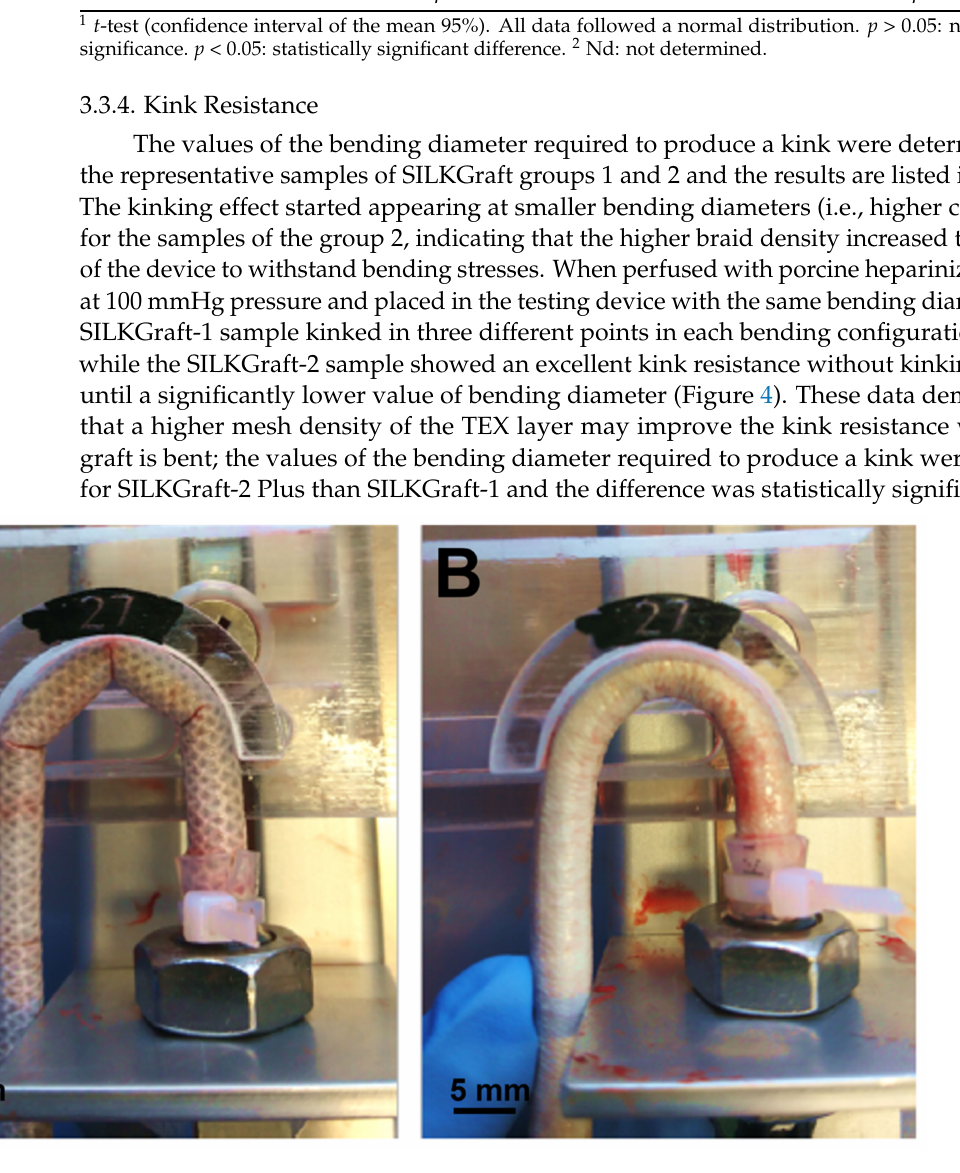
Figure 4. Kink resistance test. Images of the SILKGraft-1 ( A ) and SILKGraft-2 Plus ( B ) devices under kink resistance testing with the 27 mm diameter adapter. The SILKGraft-1 device shows three evident kinking points in the middle and in the initial and final positions of the